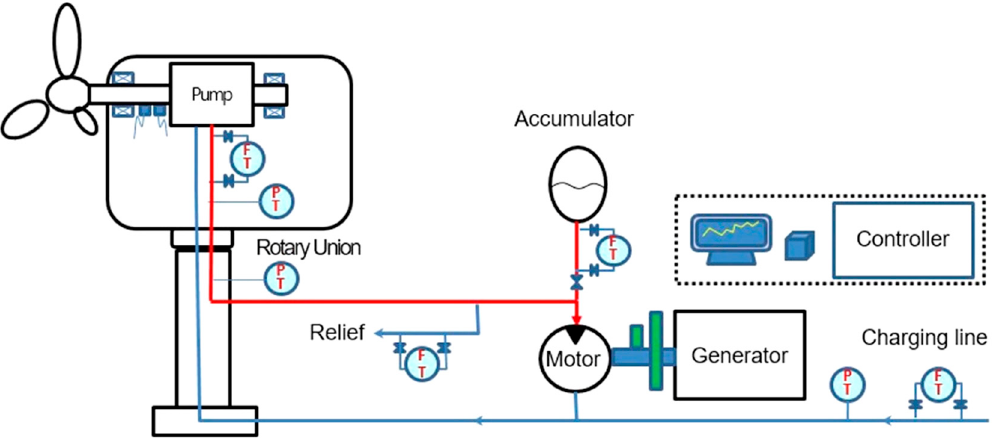
Figure 1. Schematic diagram of the wind turbine generator.